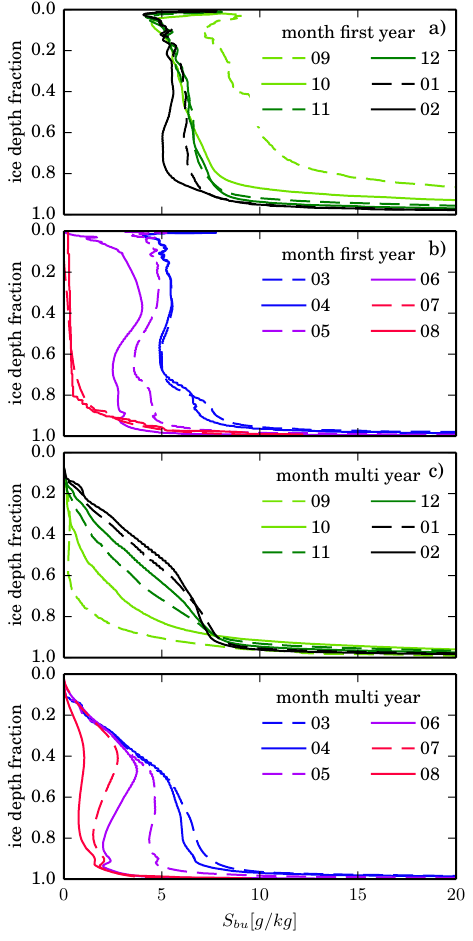
Figure 12. Monthly mean of vertically normalized salinity pro- files of reanalysis forced simulations using the complex brine dy- namic parametrizations as described in Sect. 4.1. The simulations were split into annual cycles beginning in September (month 9) and sorted into 15 years of first-year ice ( a and b ) and 21 years of mul- tiyear ice ( c and d ). The corresponding ice thickness of the monthly means are shown in Fig. 13.